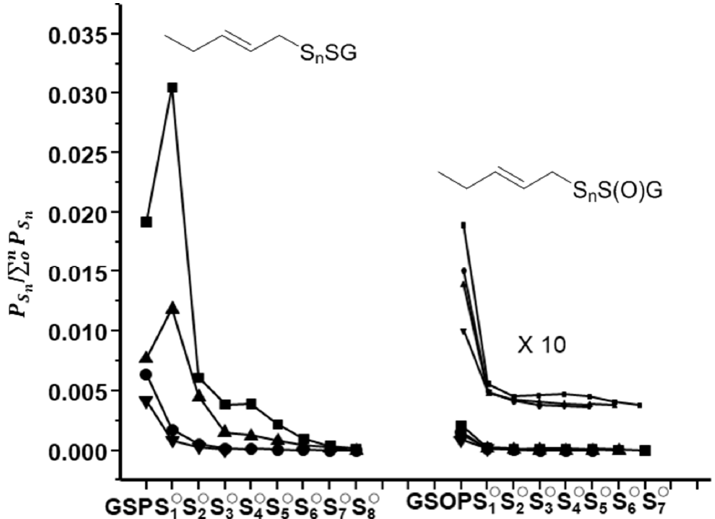
Figure 11. Relative distributions of GSS n -pent-2-ene (GSS n P), GSS n O-pent-2-ene (GSS n OP) determined from LCMS study of reaction of GSNO (1 mM) with Na 2 S (1 mM) and radical clock vinylcyclopropane (25 mM) in iP bu ff er at pH 7; (squares) in the presence of vinylcyclopropane, (up-pointing triangles) in the presence of DH and vinylcyclopropane, (circles) in the presence of IA and vinylcyclopropane, and (down-pointing triangles) in the presence of IA, DH, and vinylcyclopropane. This change does not affect the scientific outcomes as described in the text. The manuscript will be updated and the original will remain online on the article webpage. The authors would like to apologize for any inconvenience caused to the readers by these changes.